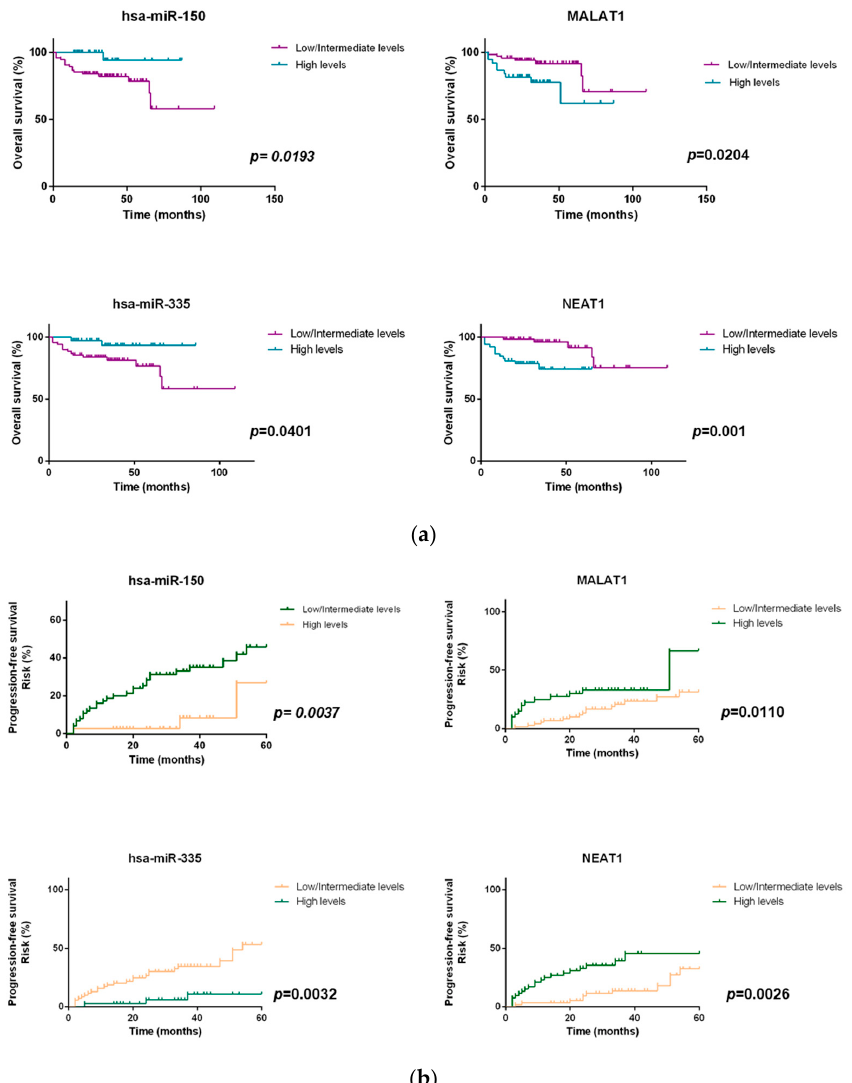
Figure 7. OS ( a ) and PFS ( b ) of NHL patients according to plasma levels of hsa-miR-150-5p, hsa-miR-335-5p, MALAT1 and NEAT1.